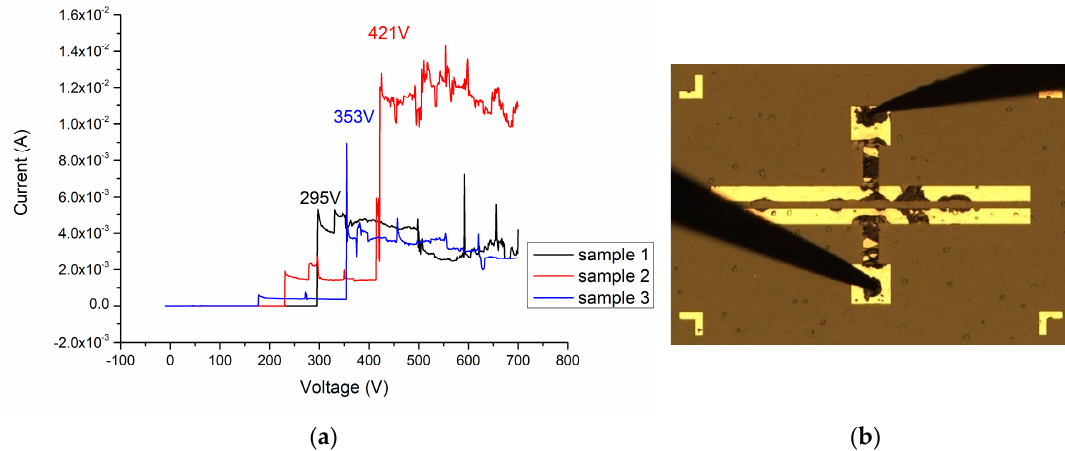
Figure 23. ( a ) I–V measurement results (sample 1 in black, sample 2 in red, and sample 3 in blue) and ( b ) breakdown image of the MOSOM varactor (with a 156 nm thick Ga 2 O 3 thin film) after the oxygen furnace annealing process at 500 °C for 4 min.